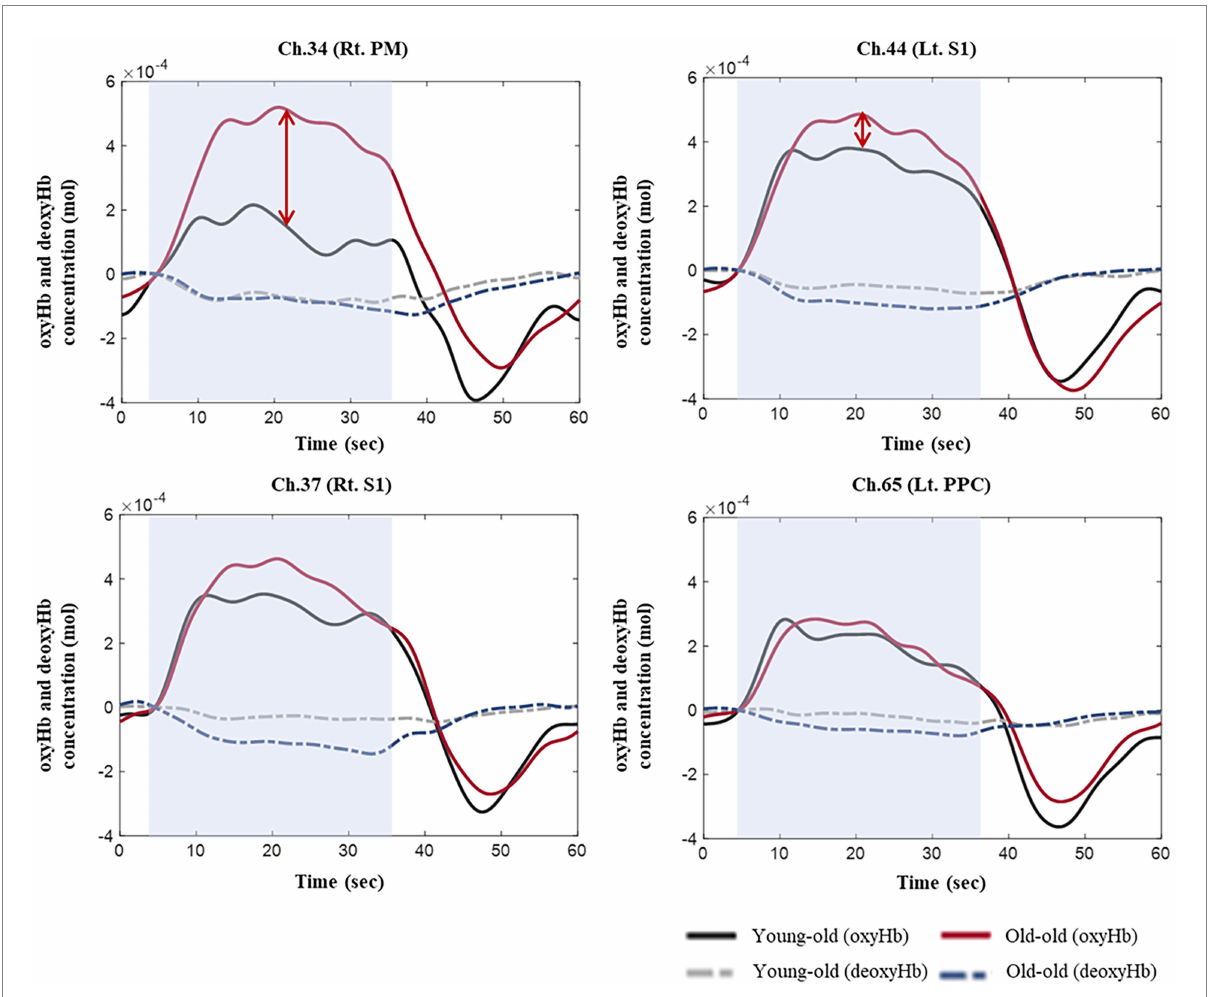
FIGURE 2 OxyHb and deoxyHb concentrations during comfortable walking in the young-old and old-old